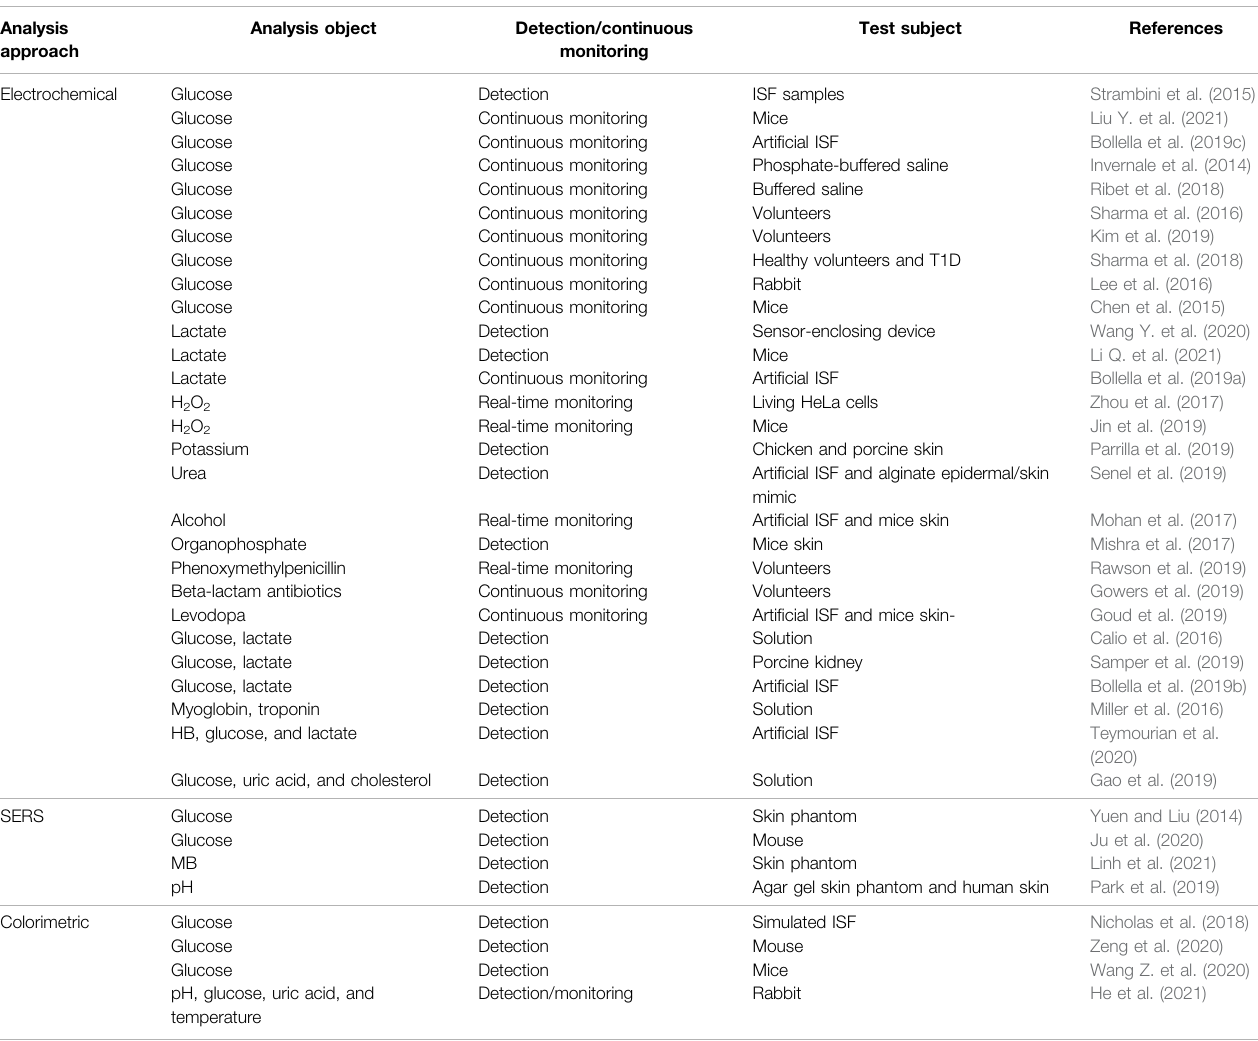
TABLE 3 | Properties of MN-based